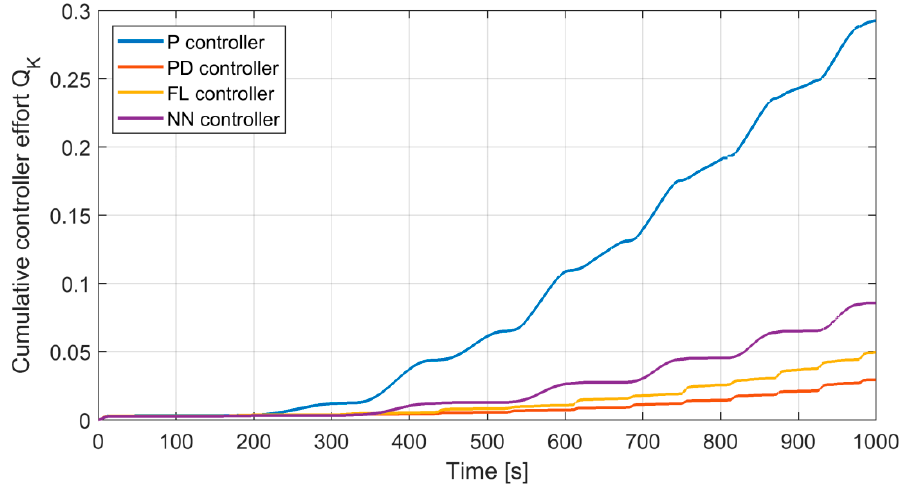
Figure 19. The cumulative effort of the four investigated controllers in 1000s time horizon by chirp set-point.